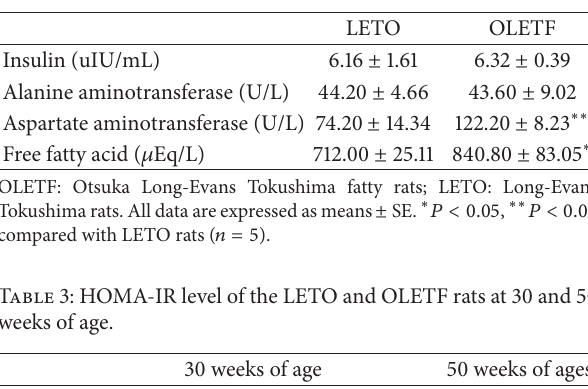
Table 1: Sequences of primers. Table 2: Biochemical analyses of serum obtained from the LETO and OLETF rats at 50 weeks of age.